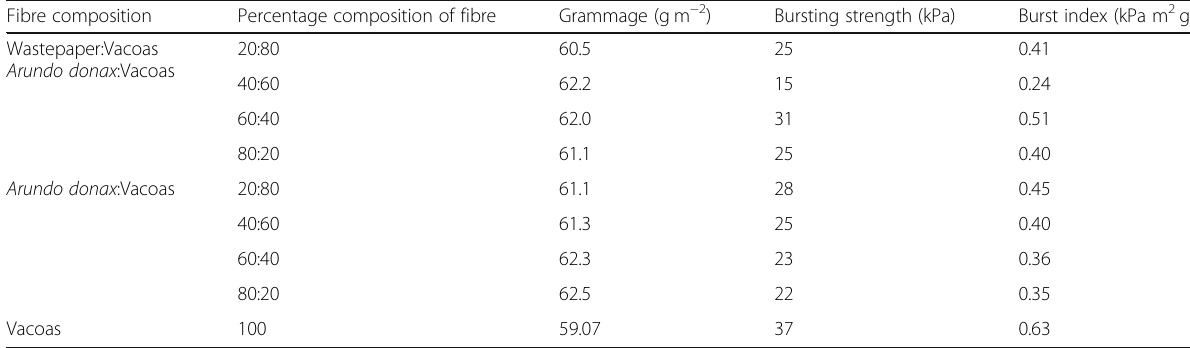
Table 2 Mean burst index of the different paper samples Fibre composition Percentage composition of